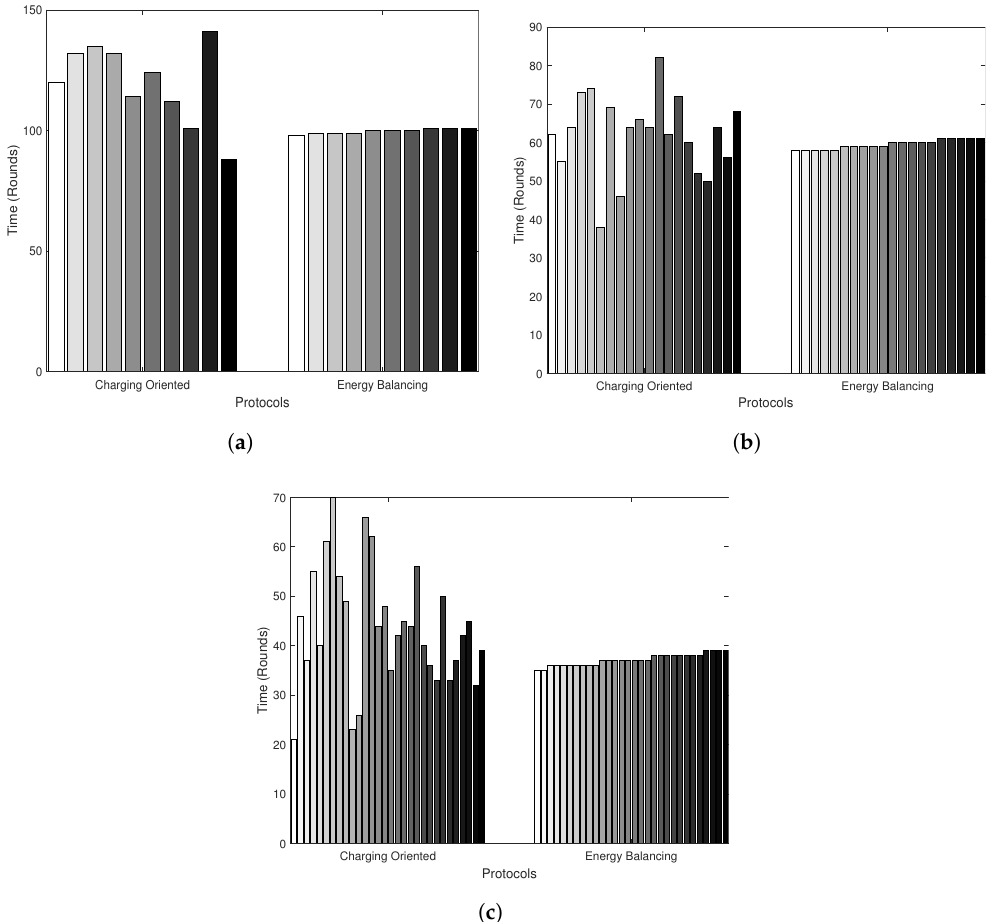
Figure 7. Lifetime of the chargers for ( a ) 10, ( b ) 20 and ( c ) 30 chargers